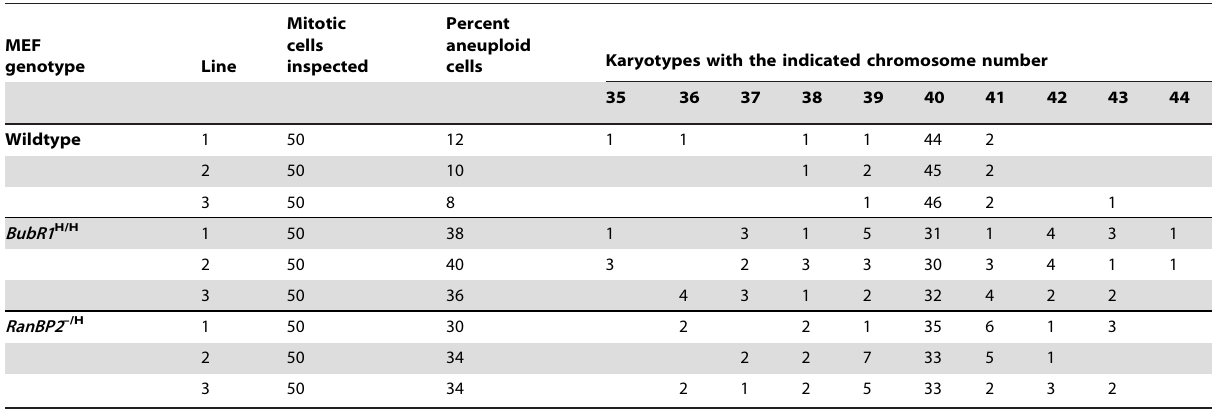
Table 1. MEF aneuploidy rates prior to